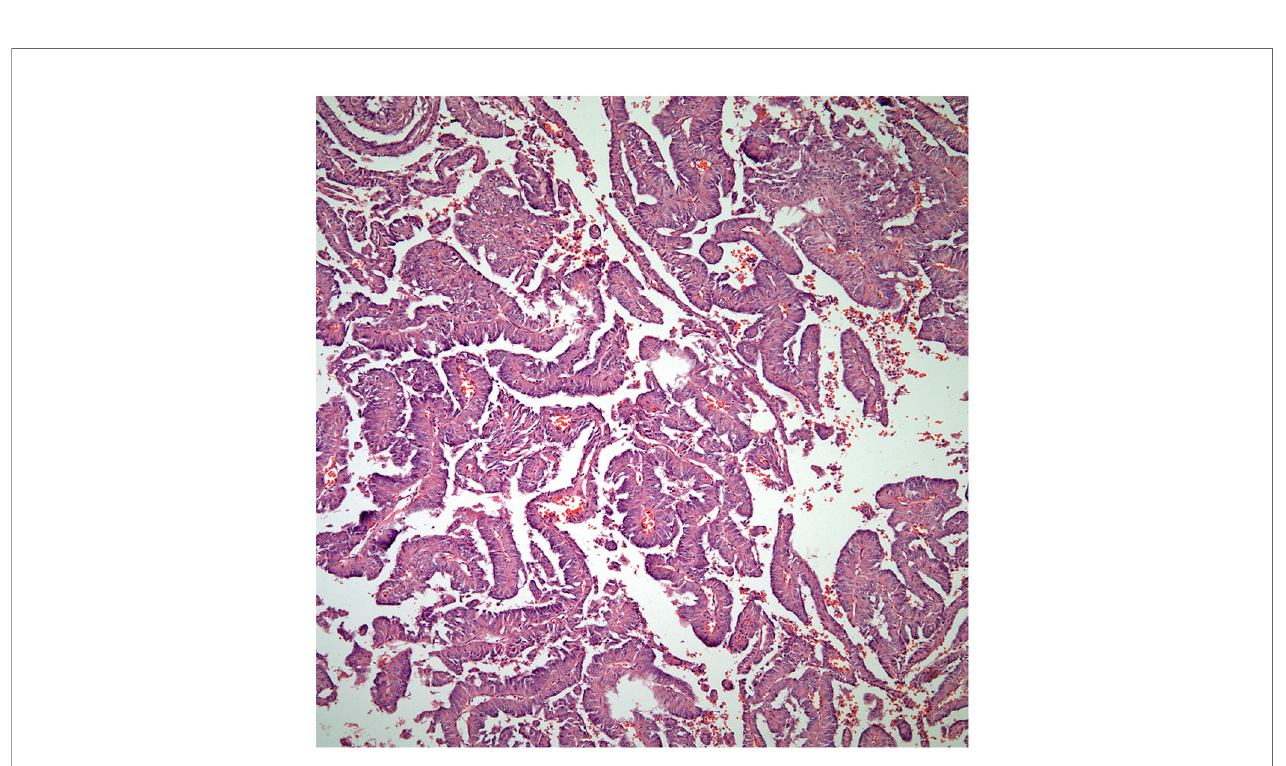
FIGURE 5 | Thymic papillary